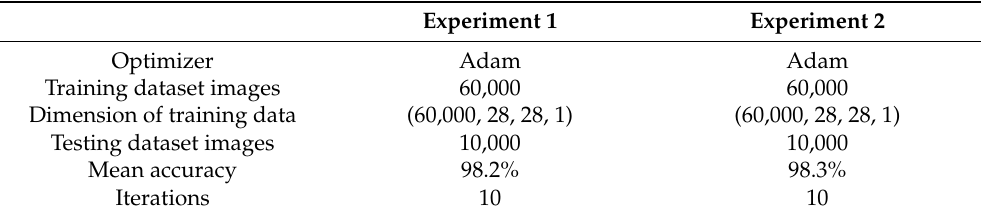
Table 3. Experimental